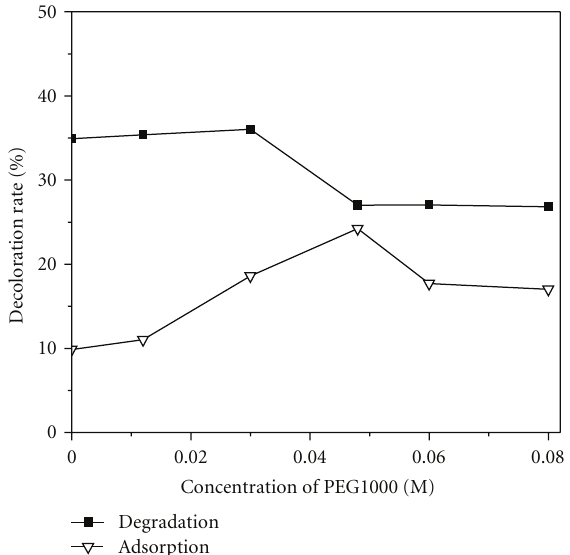
Figure 6: E ff ect of C PEG1000 on the photocatalytic activity and adsorption of mesoporous TiO 2 -Al 2 O 3 binary oxides.